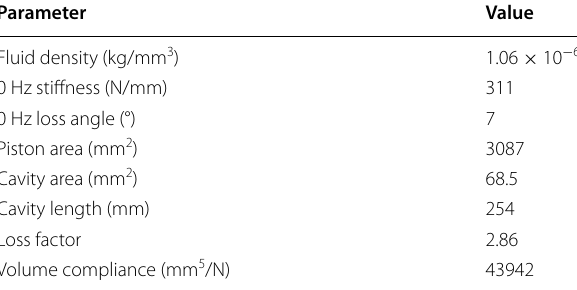
Table 2 Key parameters of hydraulic